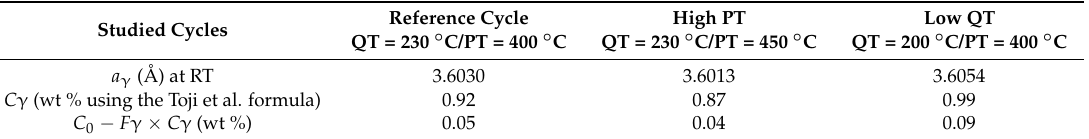
Table 3. Carbon mass balances in austenite and in the bcc phases at room temperature (RT) after the different studied cycles. The carbon contents in austenite were deduced from the measured austenite lattice parameter at RT using the Toji et al. formula